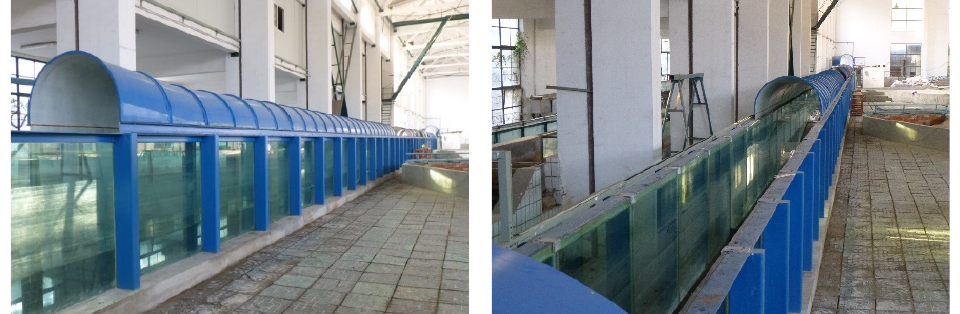
Figure 2. Sketch of the experimental flume. For wave energy conversion, a buoy was made by a hollow steel buoy of elliptical cylinder (Figure 3), which was installed at the incident side of the wavy bottoms with a distance of 33 m to the wave maker. Its dimensions are: the semi-major axis R a = 0.75 m, semi-minor axis R b = 0.3 m, height H buoy = 0.45 m, quality m = 25 kg. The reason for choosing the buoy with an elliptical cross-section was that its minor axis occupies less space of the width of the flume; reflection of incident waves can be reduced to obtain a stabler wave field.